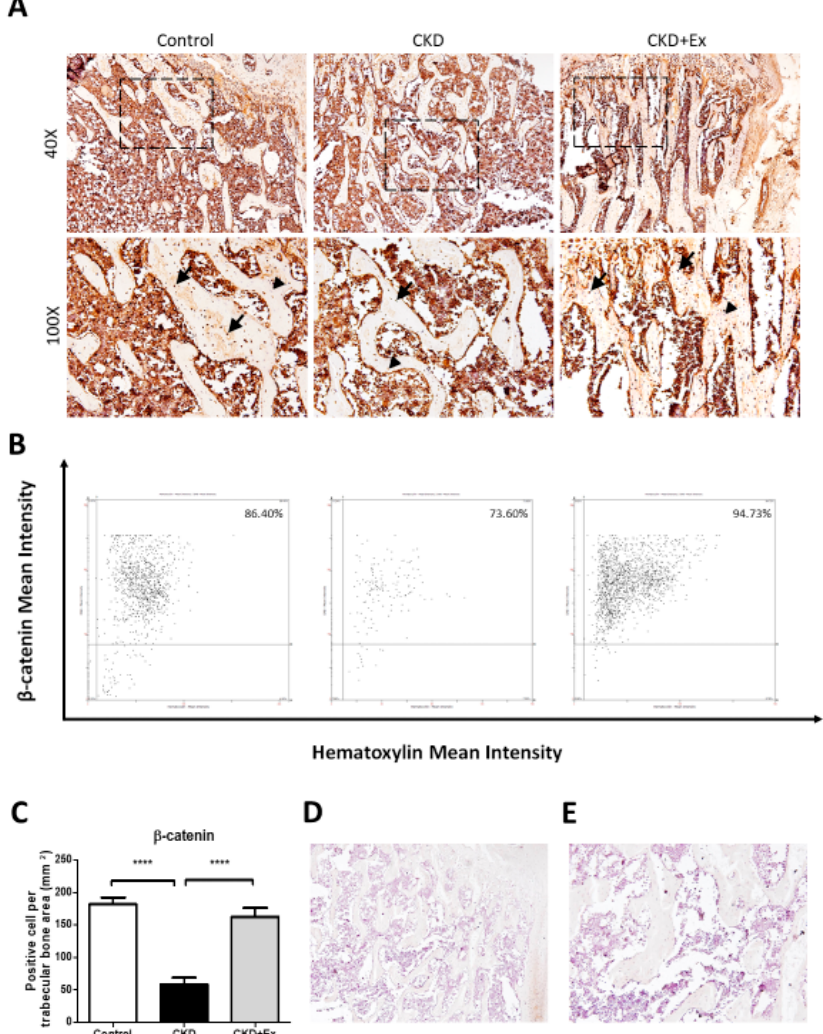
Figure 4. β -catenin immunohistochemistry on osteocytes in the tibial trabecular bone. ( A ) Protein expression of β -catenin in the trabecular bone of rats was determined by IHC assay. Rats from the CKD + exercise group showed a higher β -catenin staining signal on osteocytes than in case of rats from the CKD group. The arrows indicate the positive cells. The arrowheads indicate the negative cells. ( B ) Representative images of tissue cytometry using HistoQuest software. β -catenin-immunoreactive (IR) positive and negative cells were counted and the signal intensity was quantified. ( C ) Images are representative and quantification data are presented as the mean ± SD from 5 rats in each group. The CKD group showed a significant di ff erence compared to the CKD + exercise and sham groups (**** p < 0.0001). The CKD + exercise group showed no significant di ff erence compared to the sham group. The analysis was performed using the One way-ANOVA test. ( D ) 40 × and ( E ) 100 × images of the negative control without primary antibody.